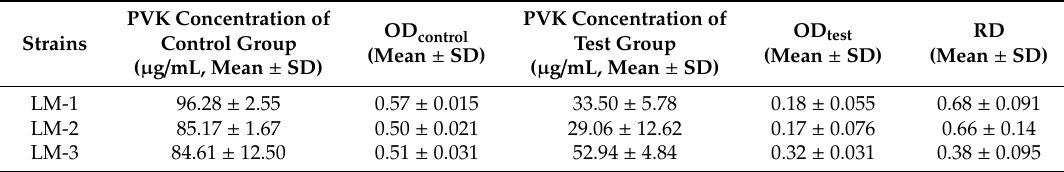
Table 1. Measured absorbance values and calculated penicillin V potassium (PVK) concentrations for three isolated